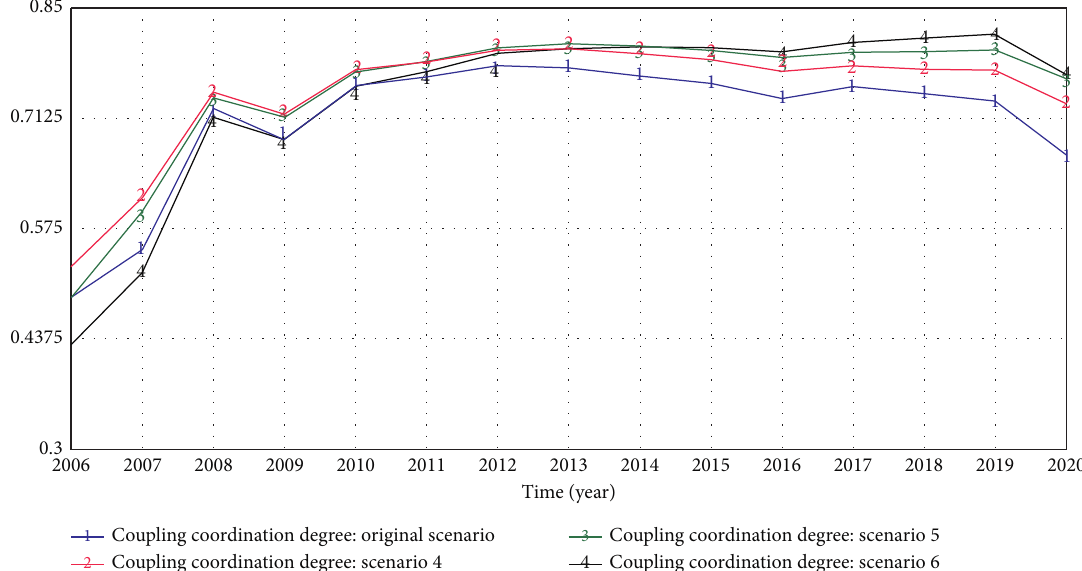
Figure 7: Influence of mixed factor change on the green low-carbon development level of coal